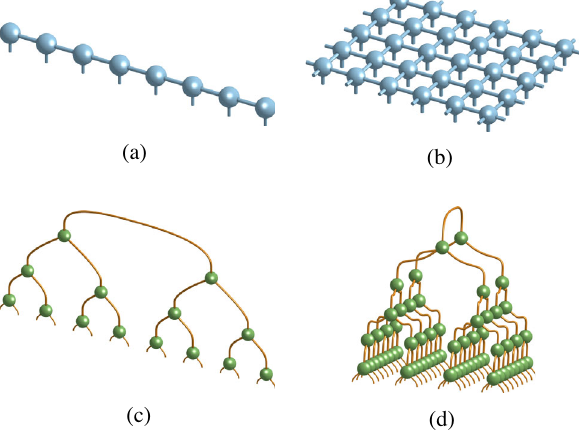
FIG. 13. Tensor network representations for a quantum many- body wave function: the matrix product states (MPS) (a) and the tree tensor network (TTN) (c) on the left hand side are for 1D systems, while the projected entangled pair states (PEPS) (b) and the TTN (d) on the right hand side represent 2D